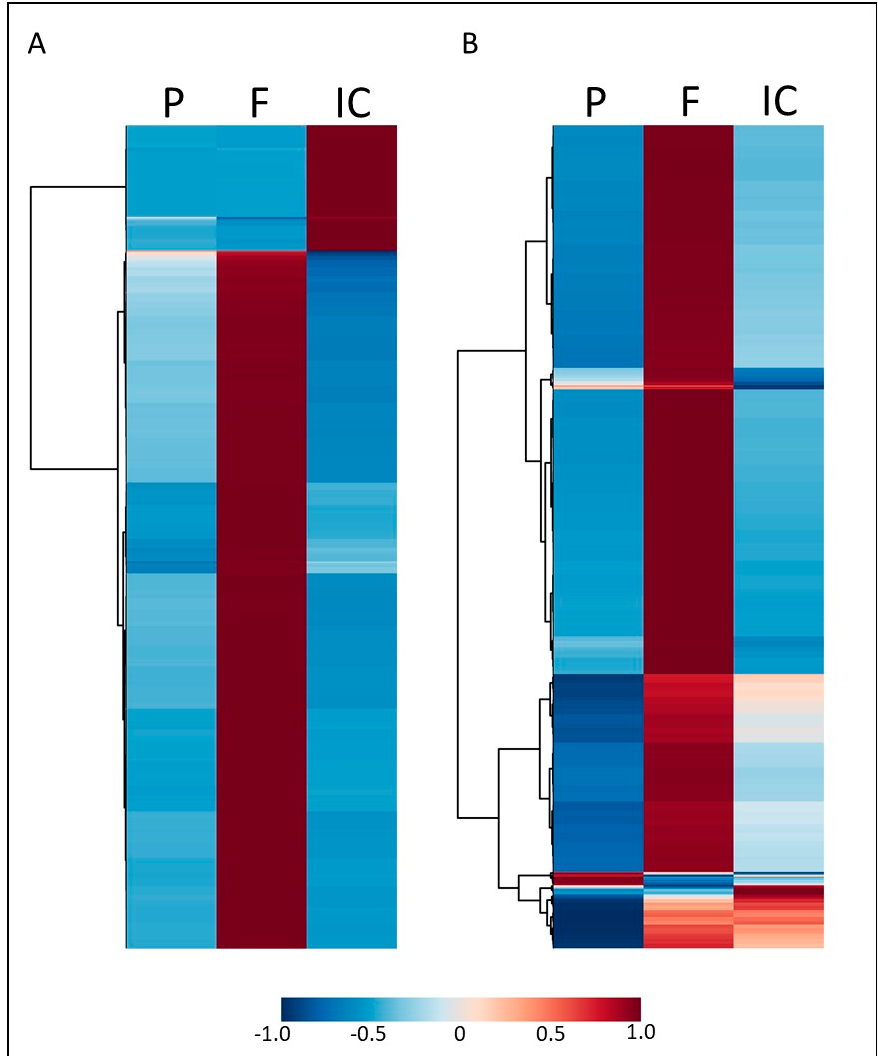
Figure 2. Distribution and abundance of metabolites across sample types . ( A , B ) Heatmaps showing the relative abundance of each MF (with hierarchical clustering) across the experimental sample types for ESI- ( A ) and ESI+ ( B ). Sample types are plant-only (P), fungus-only (F) or indirect contact (IC).